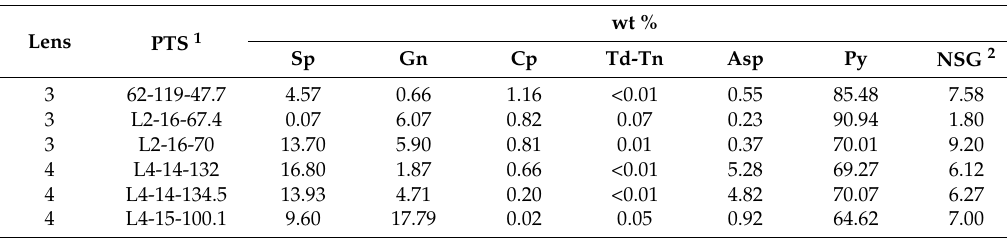
Table 3. Mineral liberation analysis modal mineralogy results.